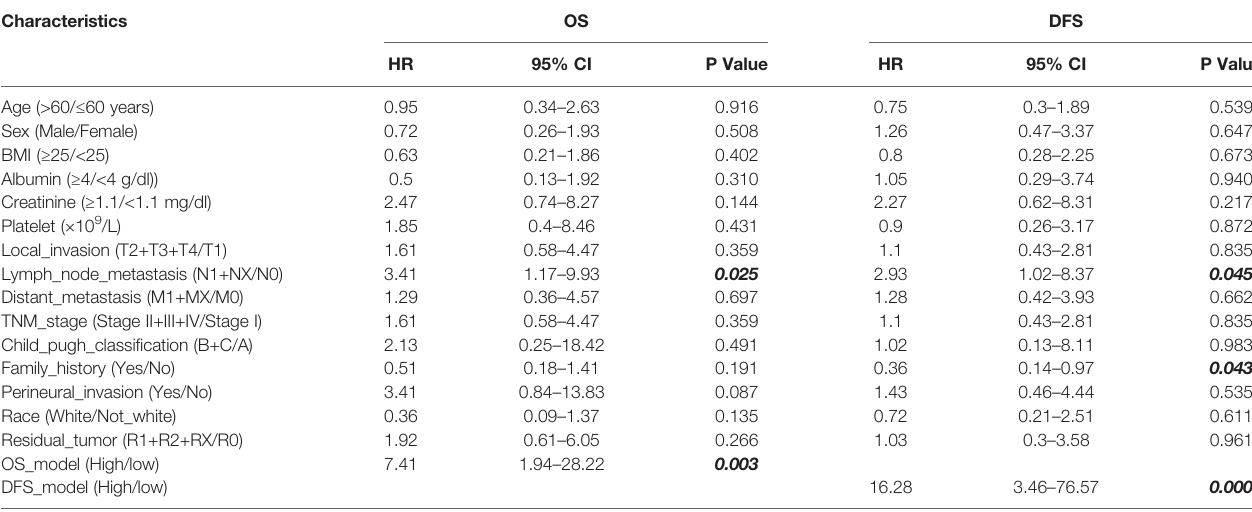
TABLE 2 | Univariate analyses of clinicopathological features for OS and DFS in ICC. Characteristics